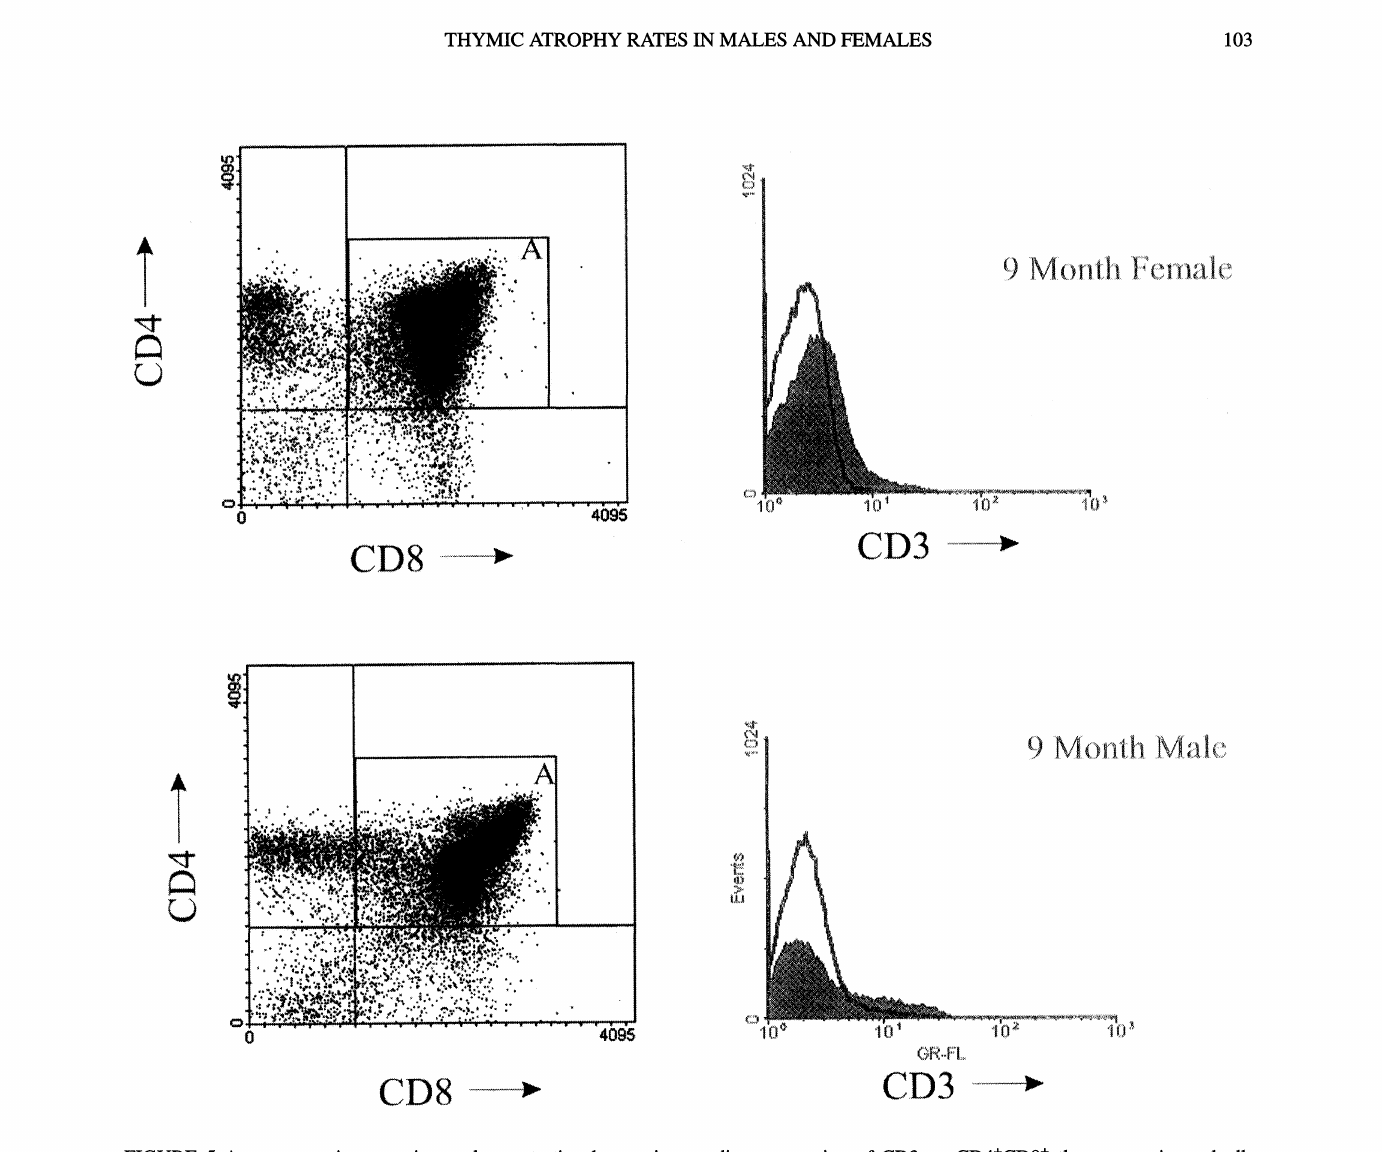
FIGURE 5 A representative experiment demonstrating low to intermediate expression of CD3 on CD4+CD8 thymocytes is markedly reduced in males but not in females by 9 months of